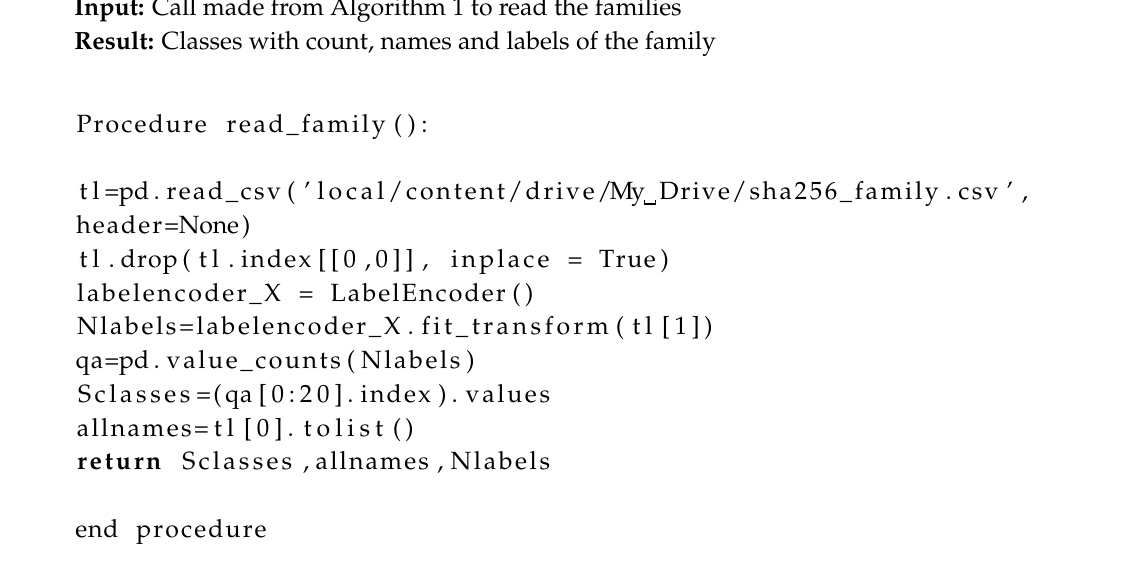
Algorithm 2: Loading the malware families from the path using the above procedure